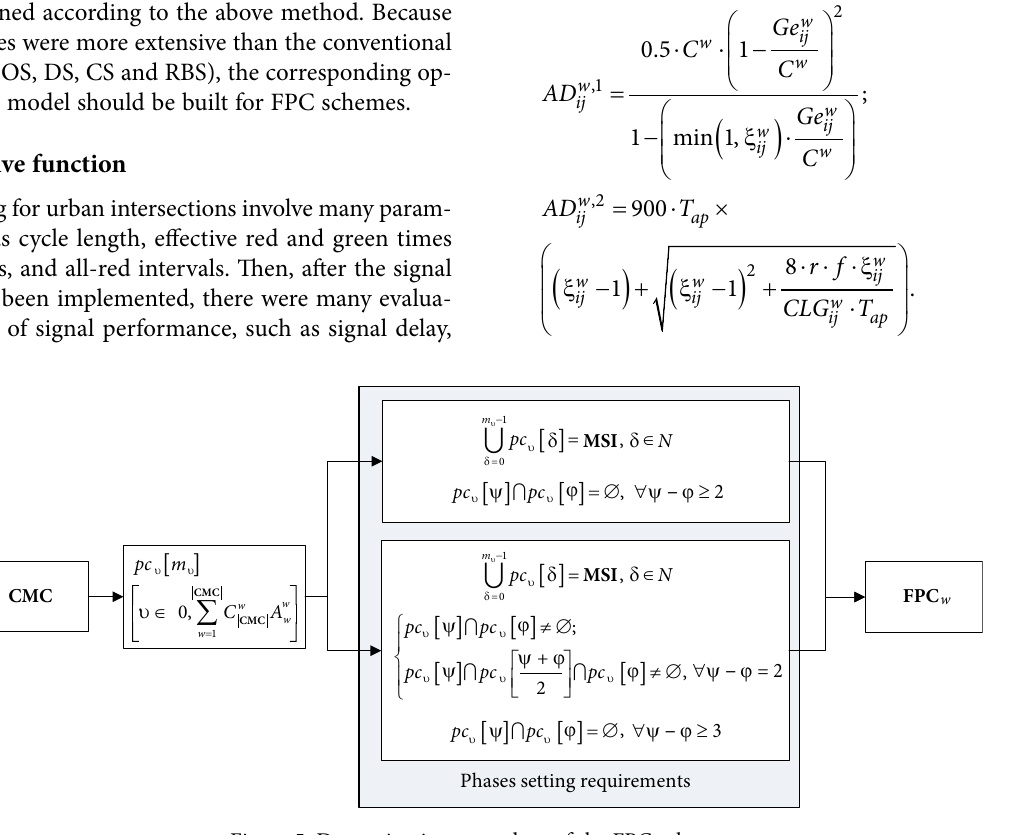
Figure 5. Determination procedure of the FPC